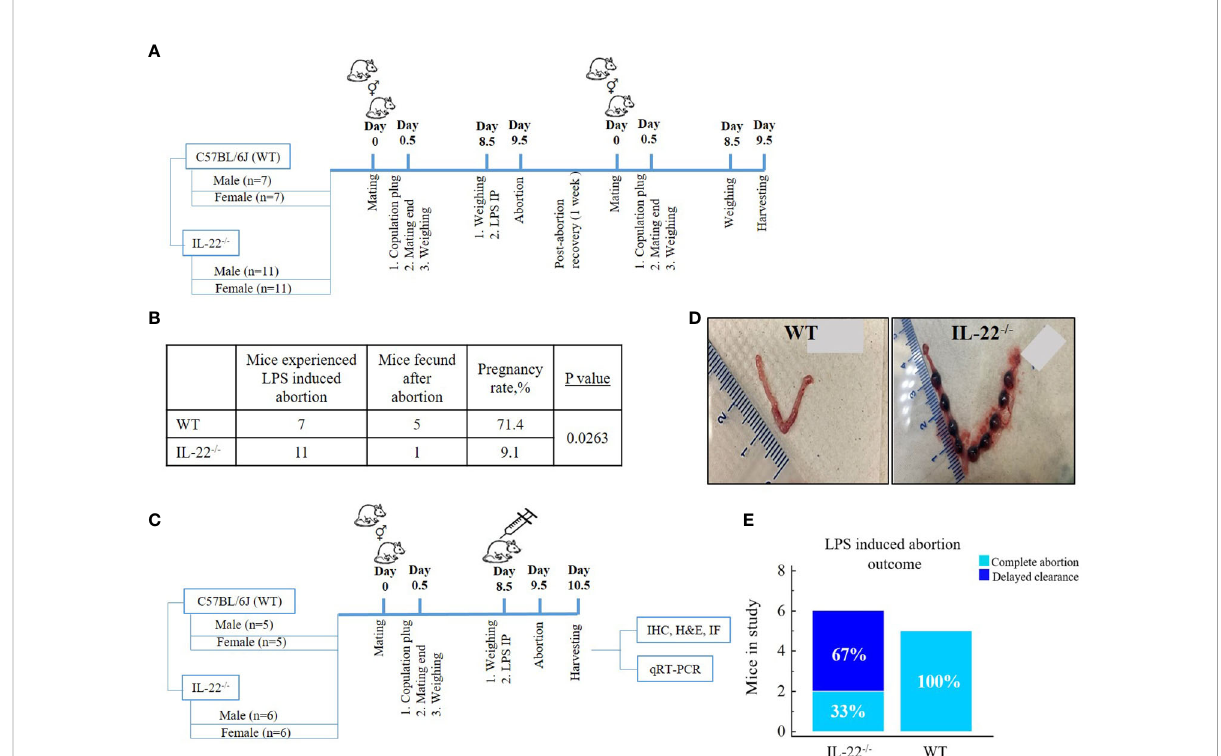
FIGURE 1 Mating schemes and outcomes. (A) Fecundity analysis: female mice were mated overnight with male mice. Females with copulation plug seen the next morning were designated as being on gestational day (gd) 0.5 of pregnancy, and further mating was over; 10µg LPS intraperitoneal injection was administered on gd 8.5. LPS-induced abortion was monitored and noted as the presence of blood in the cage on gd 9.5. After abortion, the same mice were mated again to check fecundity. (B) Fecundity table (outcome of chart A): WT mice have signi fi cantly higher fecundity rates in comparison to IL-22 − / − mice (t-test, p = 0.0263). (C) Mating to harvest experimental material: male and female mice were mated overnight and separated the next morning upon copulation plug observance. On gd 8.5, females were injected with intraperitoneal LPS endotoxin, monitored for abortion (gd 9.5), and harvested for future experiments (gd 10.5). (D) Delayed clearance after LPS-induced abortion in IL-22 − / − mice in comparison to WT mice that have complete abortion with clearance (WT, n = 5; IL-22 − / − , n = 6). Shown are representative images of uteri harvested 48 h after LPS treatment on gd 8.5. (E) In the second mating scheme, IL-22 − / − mice demonstrated aborted fetuses that remained in the uterus, while WT mice had completed abortion with total clearance (chi-square test, p = 0.09). MedCalc software was used to create the table (B) and the bar chart (E) . LPS, lipopolysaccharide; WT, wild type; IL-22 − / − , IL-22 knockout; IP, intraperitoneal; gd, gestational